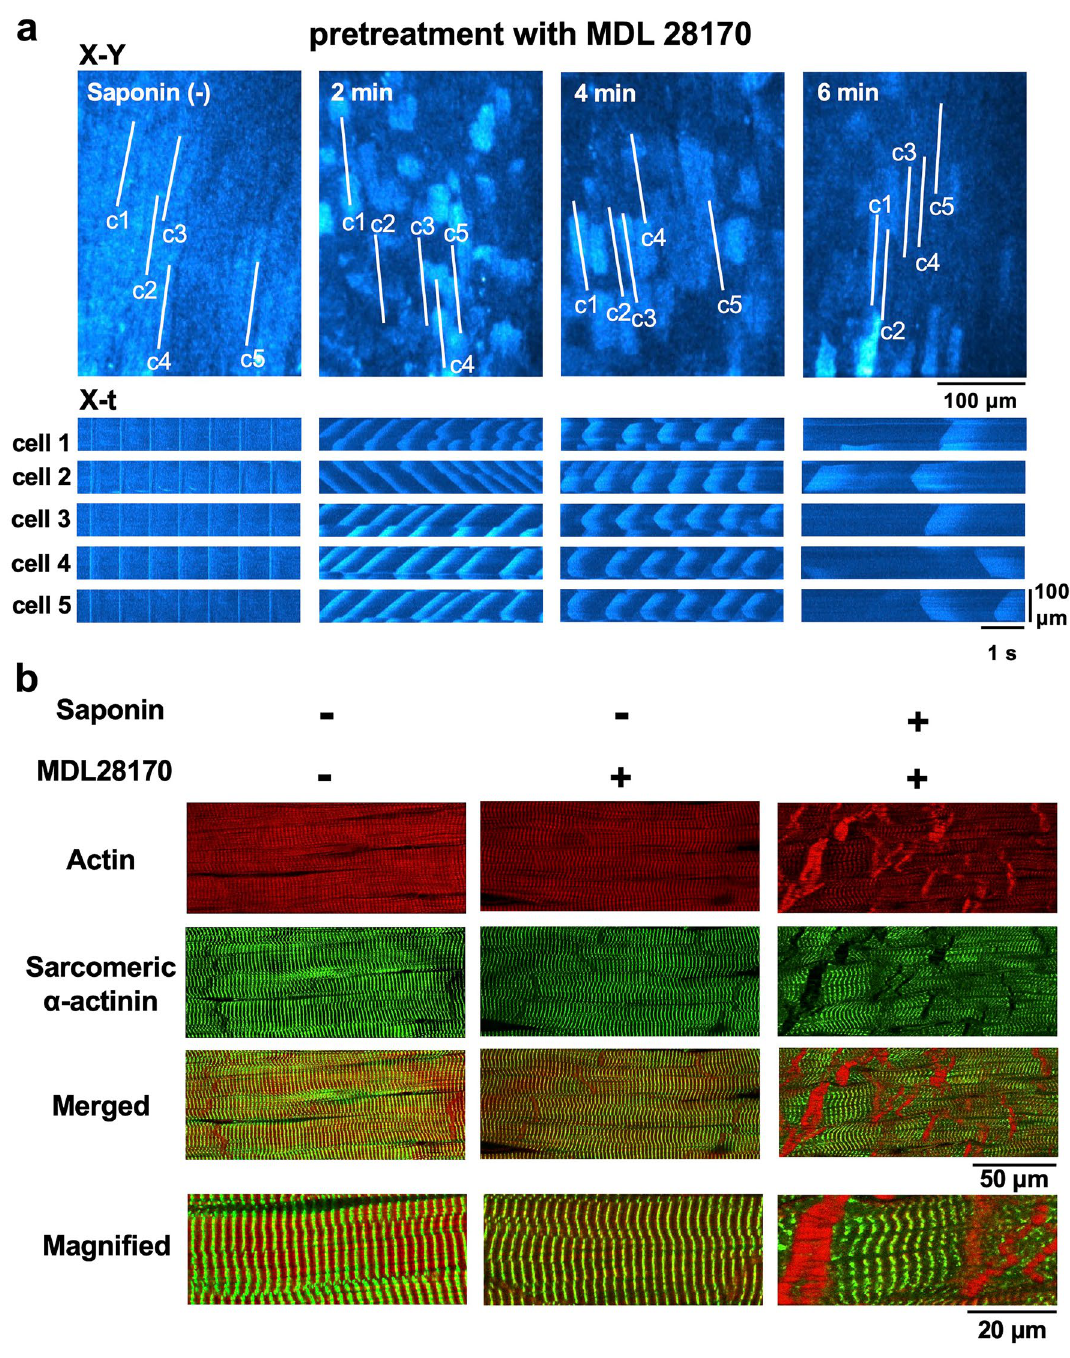
Figure 5. Role of calpain in the production of saponin-induced contraction bands. ( a ) Sequential changes in the saponin-induced Ca 2+ waves following pretreatment with MDL28170 at 100 μM. ( b ) Confocal fluorescence images of the myocardium in the absence ( left ) and presence ( middle ) of MDL28170 at 100 μM. Confocal fluorescence images of saponin-induced contraction bands in the presence of MDL28170 ( right ). Note that the saponin fails to disrupt α-actinin under pretreatment with